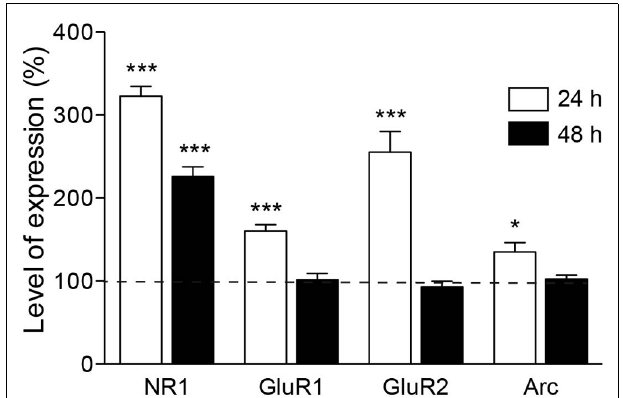
FIGURE 7 | Expression of glutamate receptor subunits is increased upon PI3K activation. Time course of mRNA expression for different glutamate receptor subunits and Arc, after PTD4-PI3KAc treatment in culture. NMDA receptor NR1 subunits were upregulated after 24 h (white box) of peptide addition and decreased after 48 h (black box). Expression levels of GluR1, GluR2 and Arc showed a similar pattern of regulation, increasing after 24 h and decreasing to basal levels after 48 h (Student’s t -test).